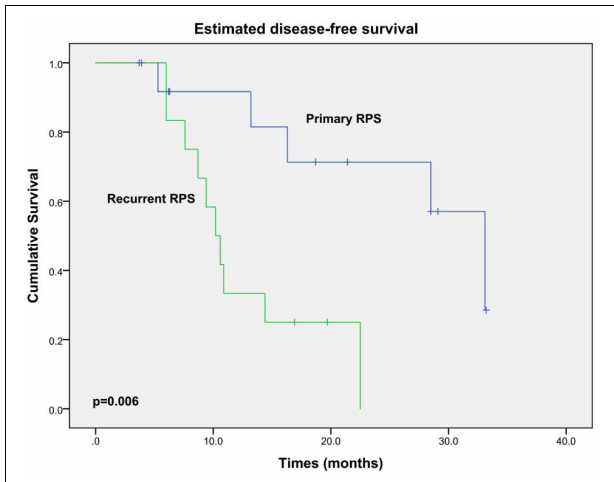
FIGURE 3 | Kaplan–Meier DFS estimates for the patients underwent PD during RPS